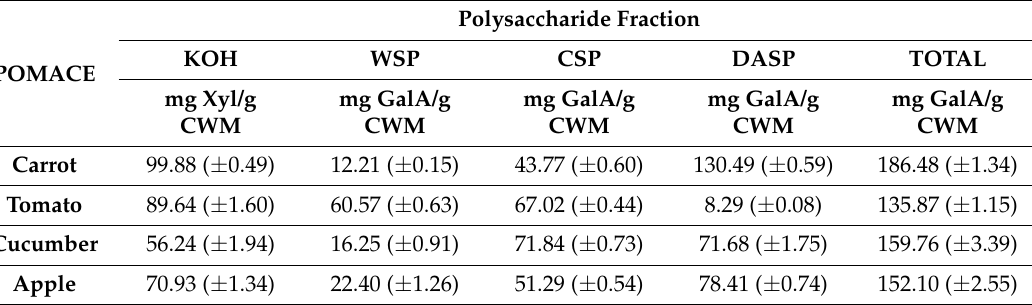
Table 2. The content of polysaccharide fractions isolated from the pomaces. TOTAL GalA is counted as sum of WSP, CSP, and DASP fractions GalA content. WSP—water soluble